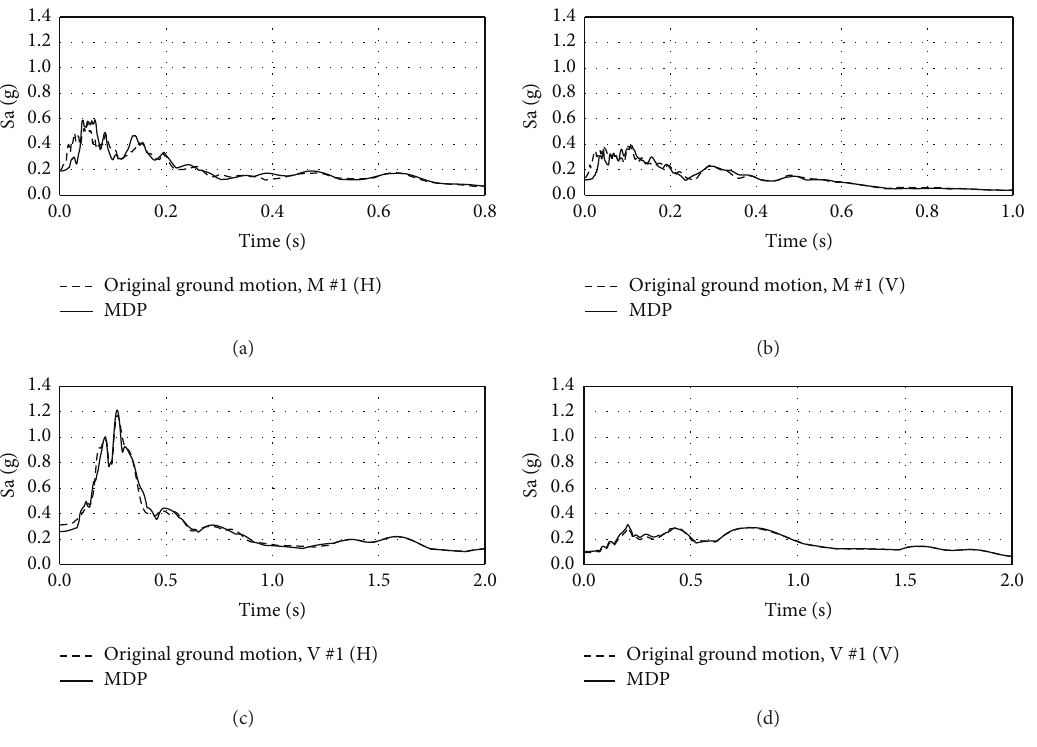
Figure 8: Deconvolved ground motions with MDP for dam-foundation, G2: (a) M number 1(H); (b) M number 1(V); (c) V number 1(H); and (d) V number